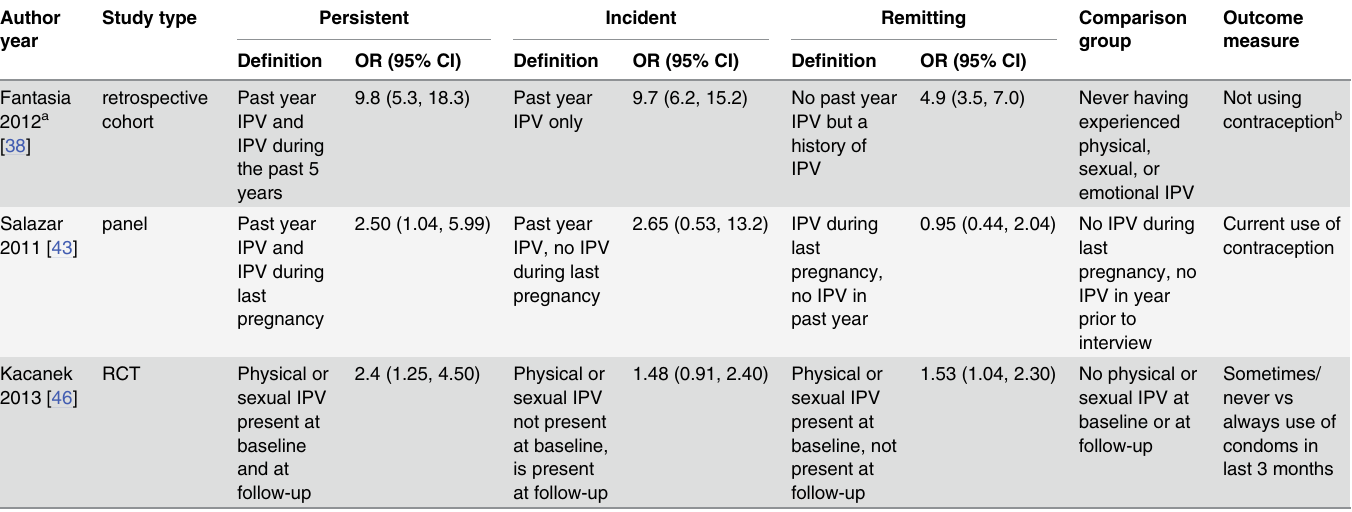
Table 3. Association between the duration of intimate partner violence and women ’ s contraceptive use as compared to women who have no history of intimate partner